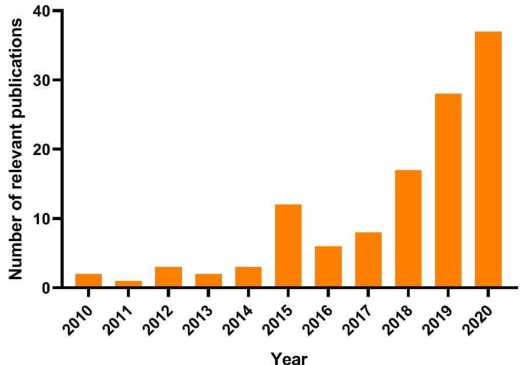
Figure 1. The number of relevant publications in the past ten years. Articles were collected from the Web of Science (WoS) Core Collection database. The search terms for the data were set as Topic: (Heavy metal contaminated soil or Heavy metal stress or Soil with heavy metal pollution) and Topic: (Plant or Botany or Crop) and Topic: (Nano or Nanomaterials or Nanoparticles or